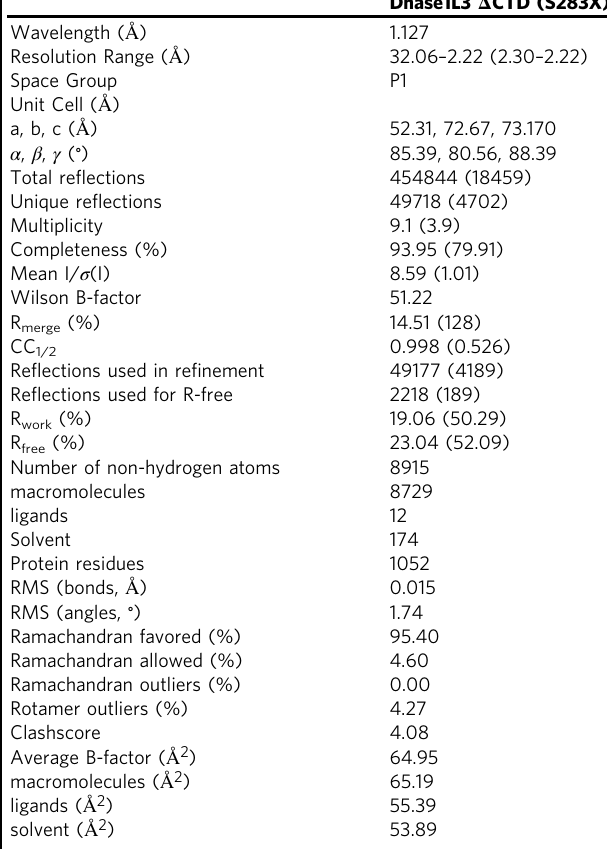
Table 1 Crystallographic data and re fi nement